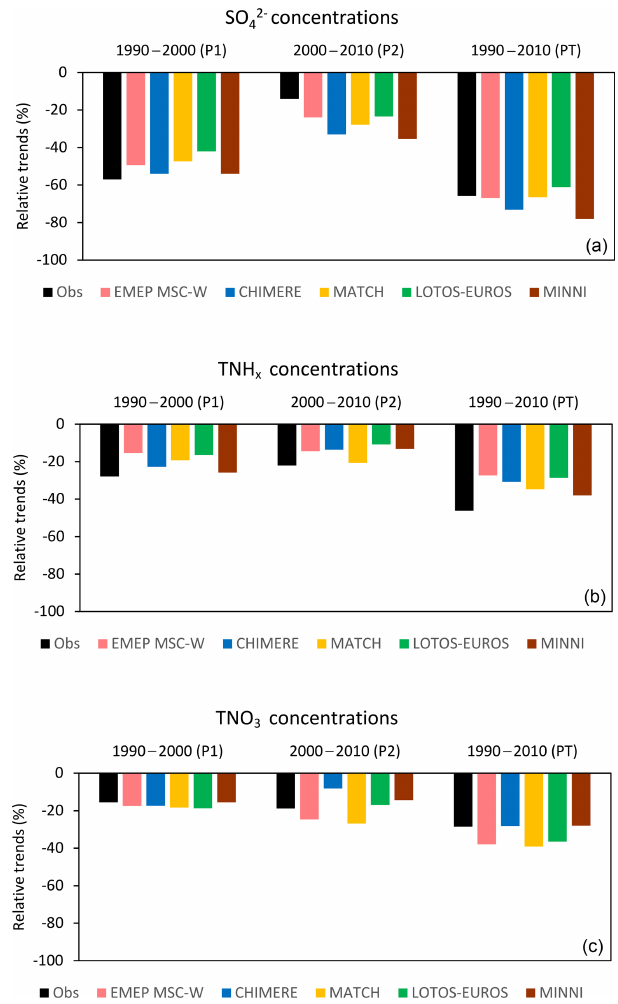
Figure 6. Modeled and observed (obs) mean relative trends in (a) SO 2 − , (b) TNH x and (c) TNO 3 concentrations for the P1 4 (1990–2000), P2 (2000–2010) and PT (1990–2010) periods.